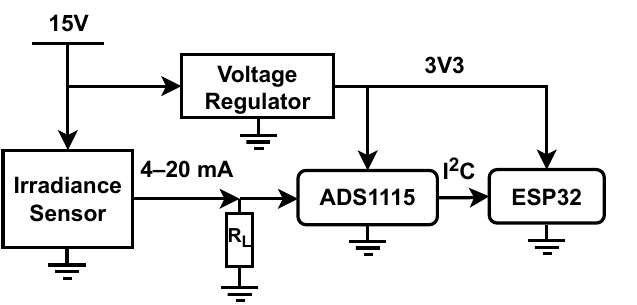
Figure 2. Electronics box diagram of one mote of the WSN.